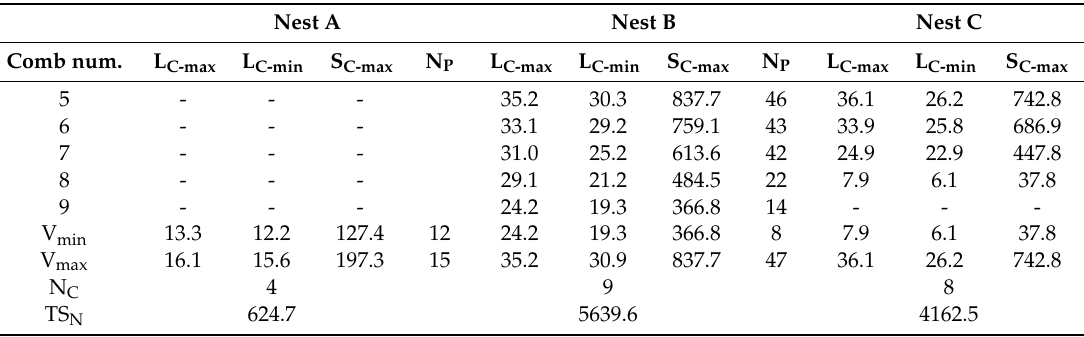
Table 2. Cont . Nest A Nest B Nest C Comb num.